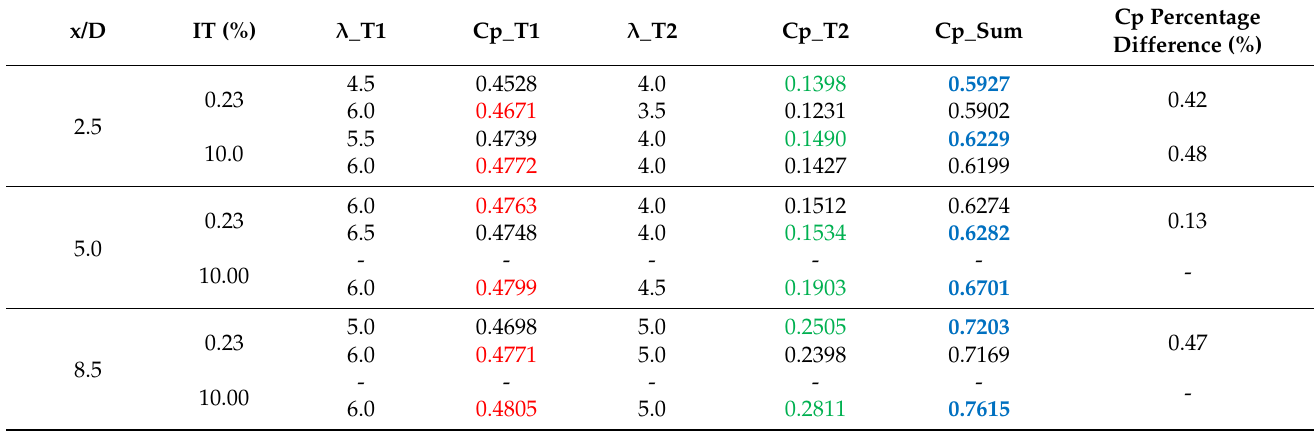
Table 3. Summary of characteristic points of turbine tandem operation (red—maximum